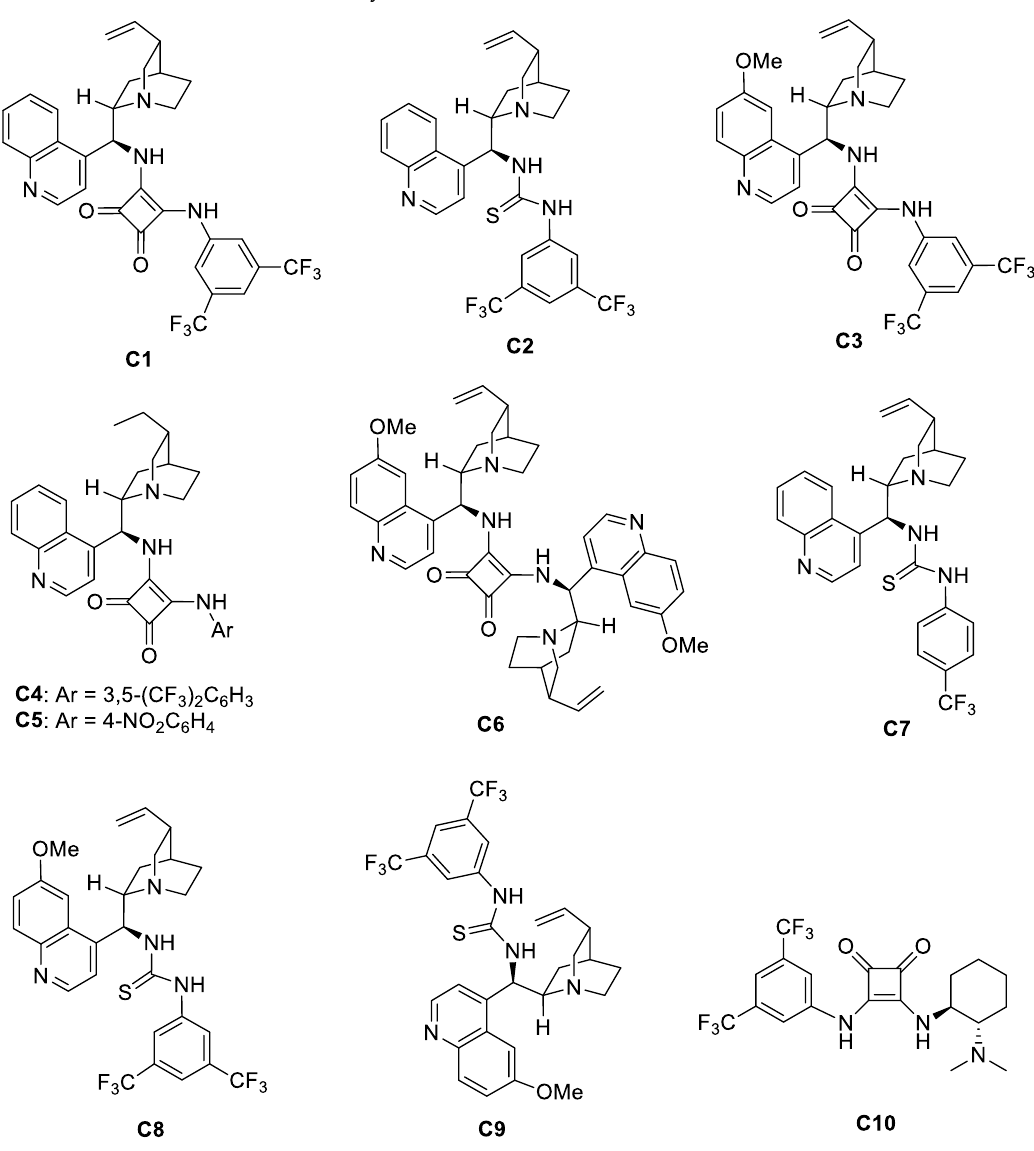
Figure 2. Organocatalysts selected.